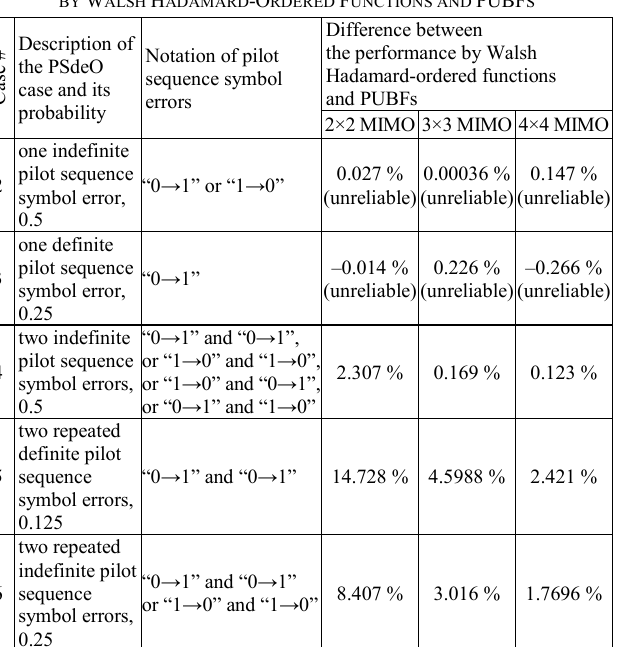
R ECAPITULATION OF THE BER P ERFORMANCE BY W ALSH H ADAMARD -O RDERED F UNCTIONS AND PUBF